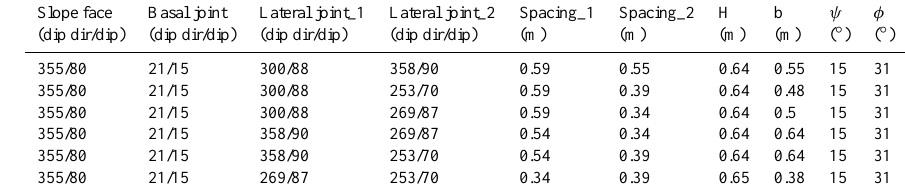
Table 5. Joint combinations and related rock block geometries compatible with topples at the Mt. Pucci cliff slope.